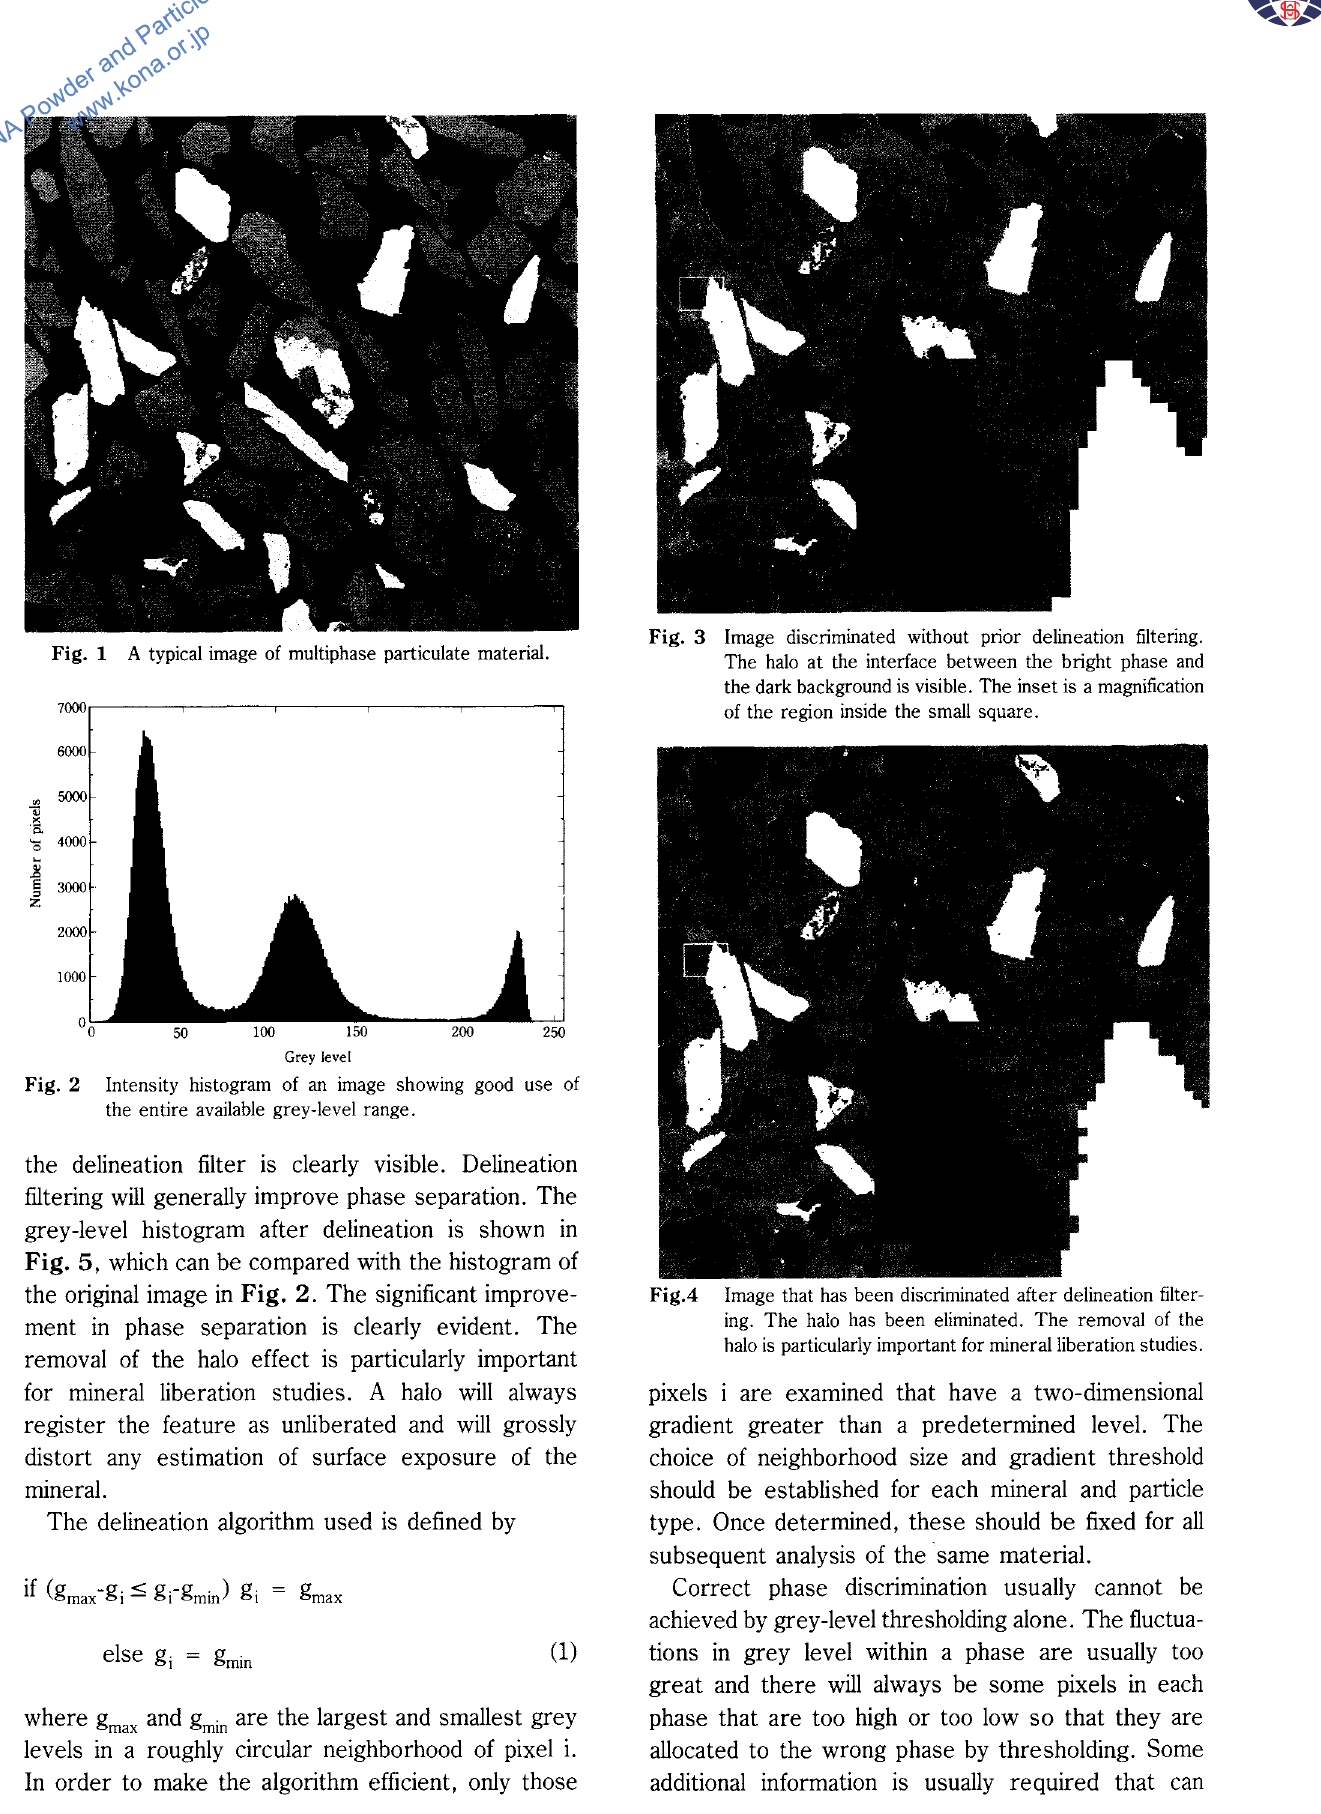
Fig. 1 A typical image of multiphase particulate material.